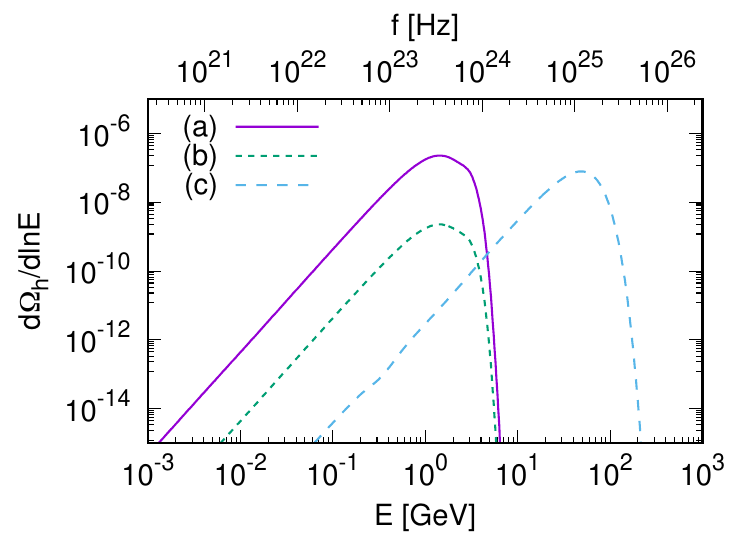
Figure 2 . The present graviton spectrum from the dark Higgs decay for (a): ( m φ , H inf , T R ) = ( 10 13 , 10 12 , 10 12 ), (b): (10 13 , 10 11 , 10 11 ) and (c): (10 12 , 10 11 , 10 11 ) in GeV unit. breaking terms of the global U(1). If ψ (and hidden sector gauge fields if any) is heavier than the axion, the only possible decay mode of the axion is that into the graviton pair. The relevant effective axion-graviton coupling is given in (2.34) and the axion decay rate into the graviton pair is given by eq. (3.1) with Λ = 192 π 2 v . The decay temperature φ